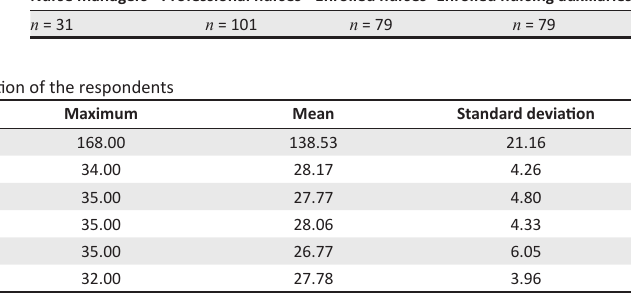
TABLE 1: Nurse managers and their teams in the mining healthcare